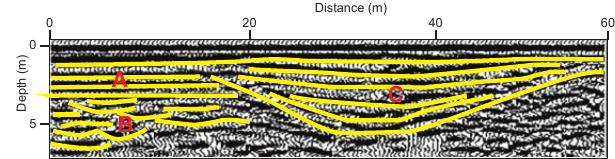
Figure 2. Interpretation by Huisink (2000) of subsurface strata from GPR data collected near Hardenberg 13km upstream of Jun- nerkoeland (see location in Fig. 1b). Horizontal strata of cover sand deposits (A) on top of the channel deposits of an interpreted braid- ing system (B). A relatively small, symmetrical palaeochannel is present (C) within the Late Glacial deposits, hereafter referred to as “Palaeochannel Q ”. Figure adapted after Huisink